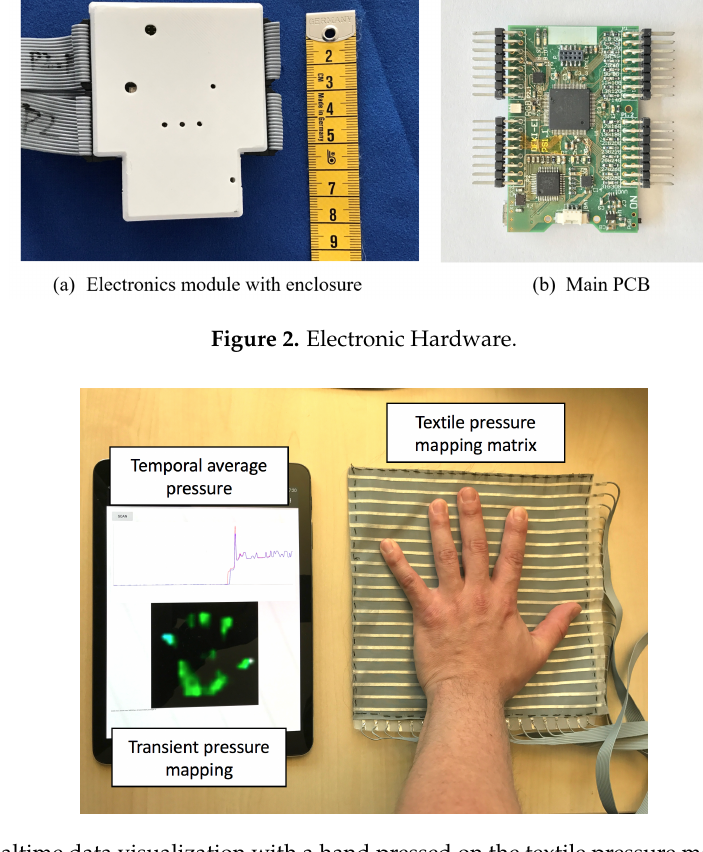
Figure 3. Realtime data visualization with a hand pressed on the textile pressure mapping